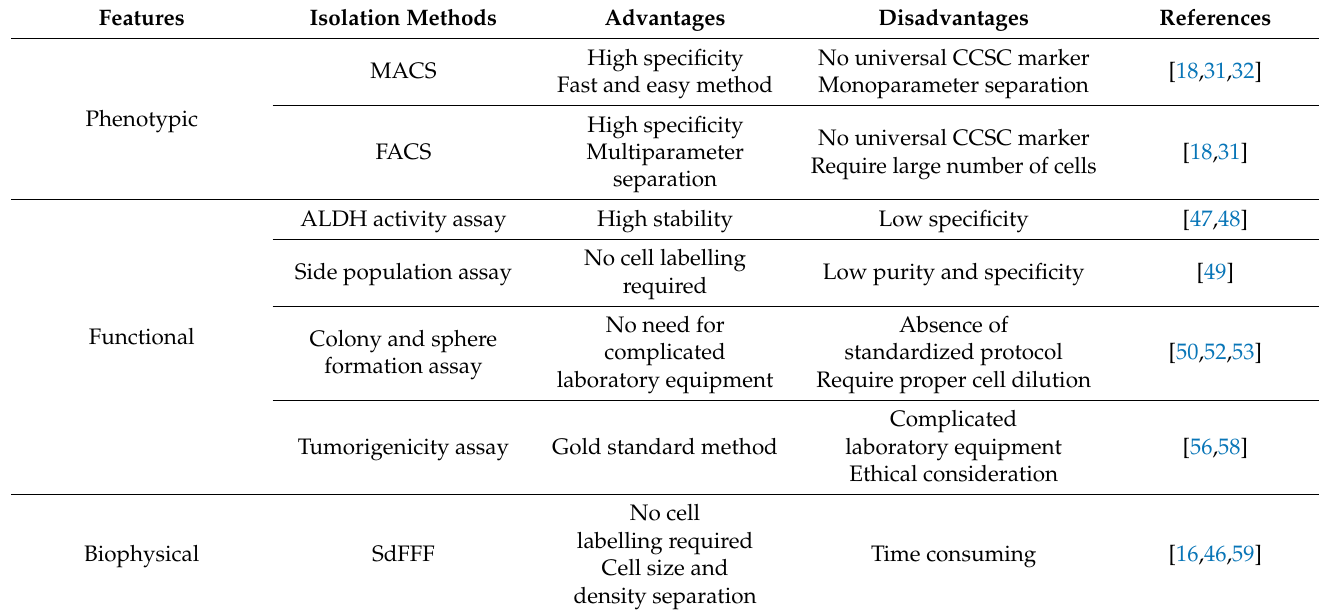
Table 3. Advantages and disadvantages of CCSC isolation